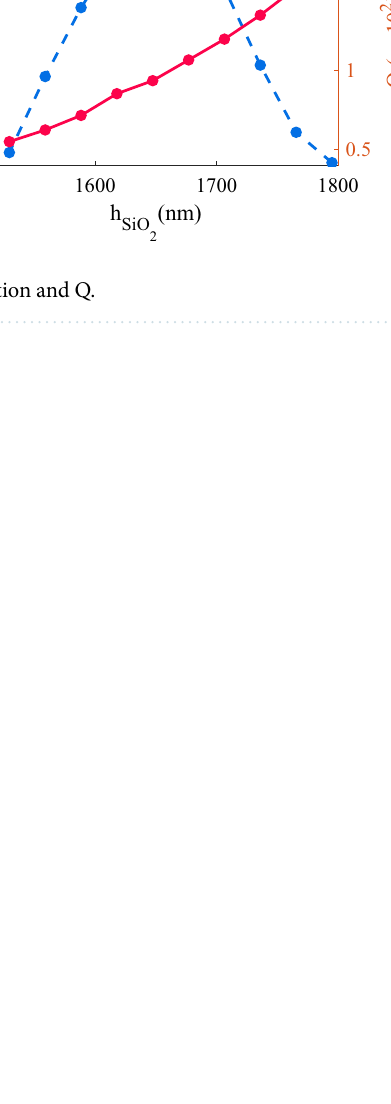
Figure 6. ( a ) and ( b ): Reflection spectra of the structure for different h SiO 2